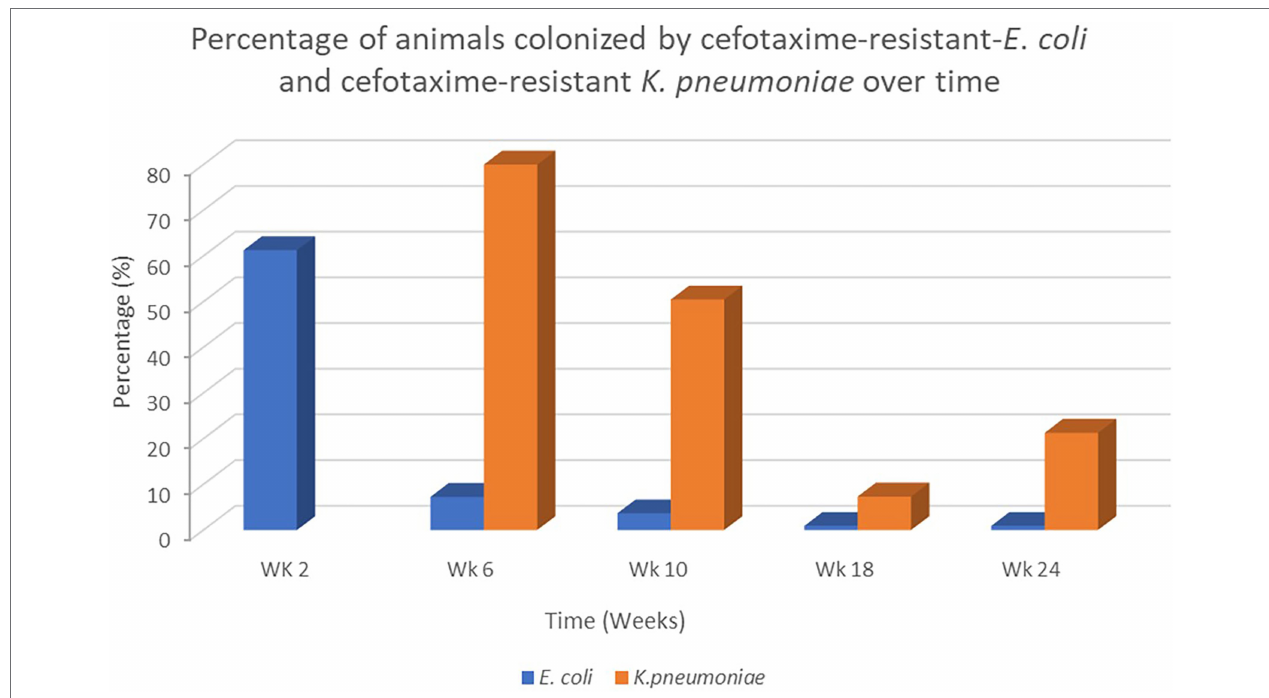
FIGURE 1 | Percentage of animals colonized by cefotaxime-resistant Escherichia coli and Klebsiella pneumoniae isolates recovered over time during the rearing period at the veal farm from week 2 after arrival of calves at the veal farm until week